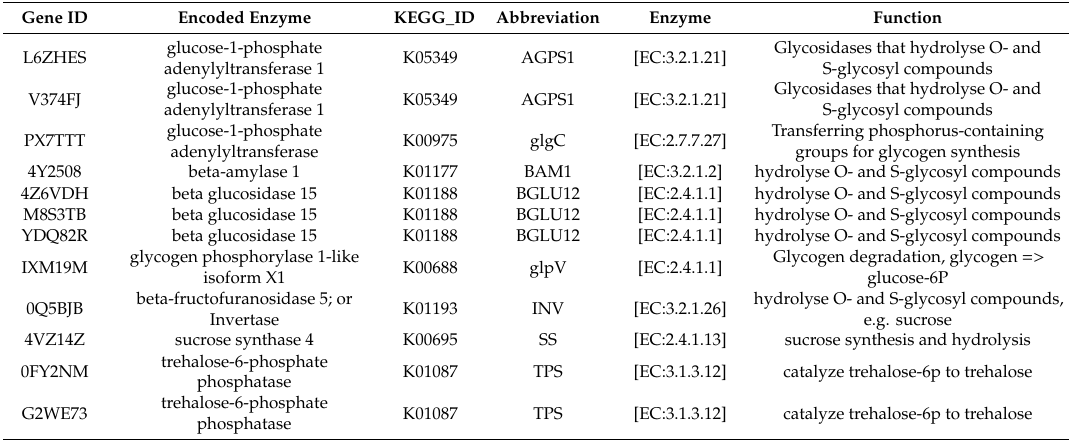
Table 5. Shade commonly regulated DEGs in starch and sucrose metabolism.